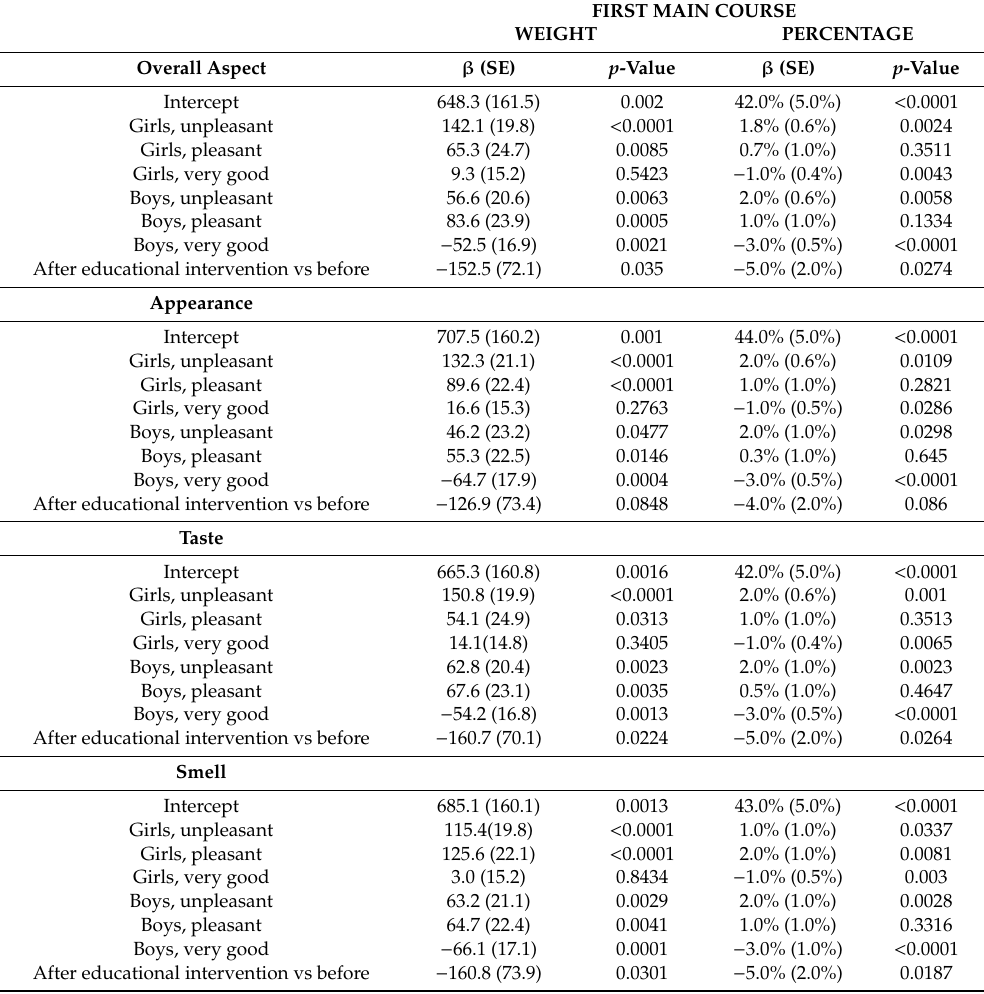
Table 5. Regression coe ffi cients of the model evaluating waste weights and percentages from the first course for numbers of boys and girls expressing pleasant, indi ff erent or unpleasant judgments on overall aspect, appearance, smell and